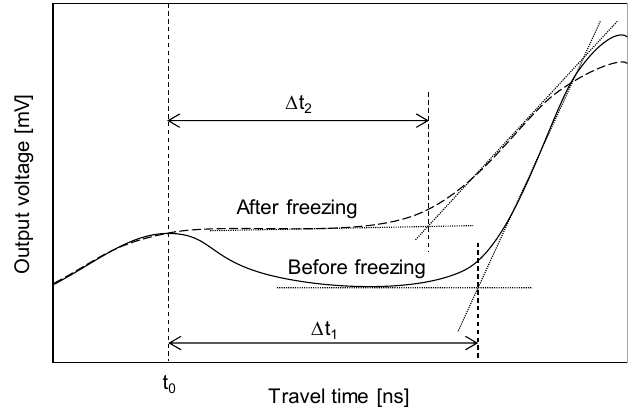
Figure 3. Conceptual TDR signals for soils before and after freezing. Table 2. Coefficients of cubic polynomial relationships between volumetric unfrozen water content and relative permittivity.